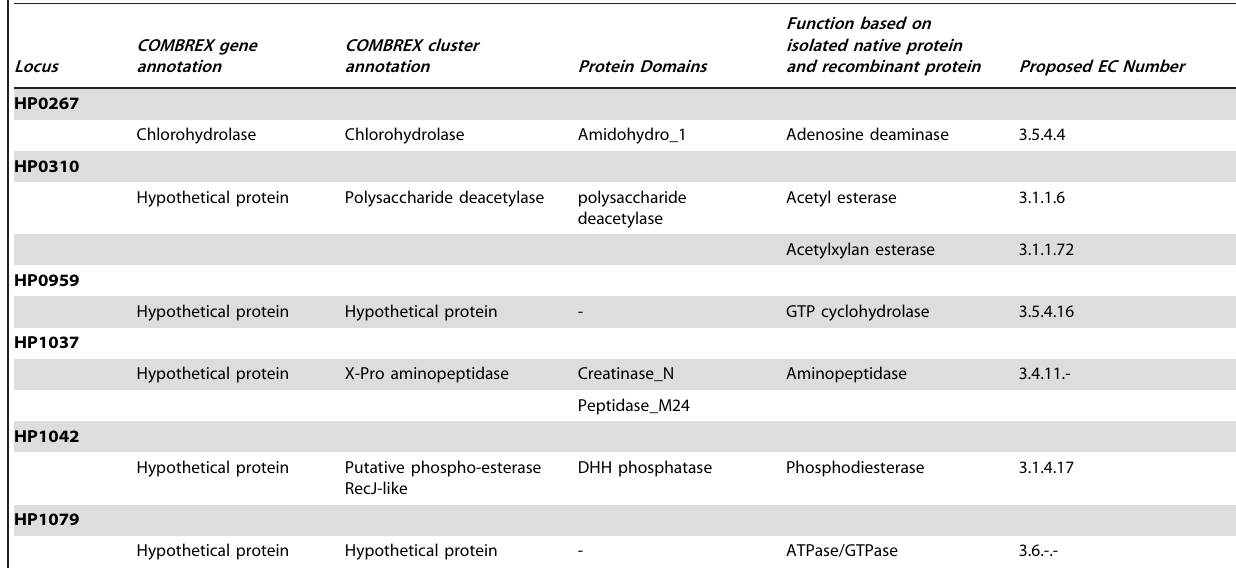
Table 2. Genes tested in this paper.